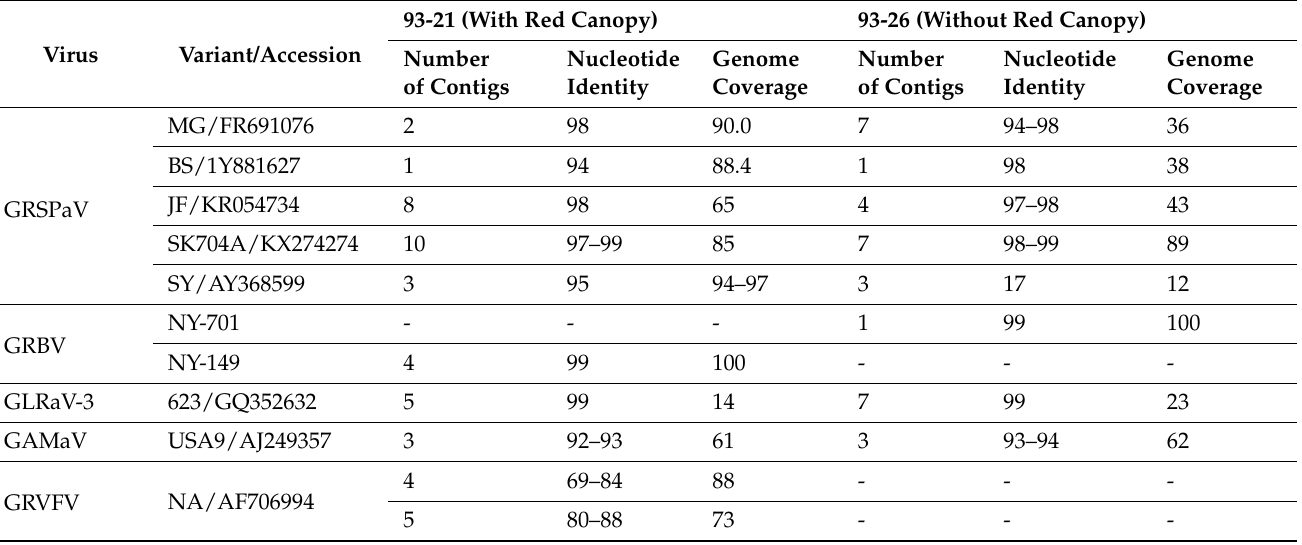
Table 5. Summary of contigs assembled from sequence reads derived from two samples of Syrah clone 100 vine (93-21 with red canopy; 93-26 without red canopy) and their corresponding viruses and viral variants. Viral contigs obtained based on de novo assembly from each of the two samples were manually compared with known viral genome sequences and assembled into variant sequences. Data pertaining to viroids are not included here as they are commonly detected as “background” and are not known to cause major diseases in grapevine.